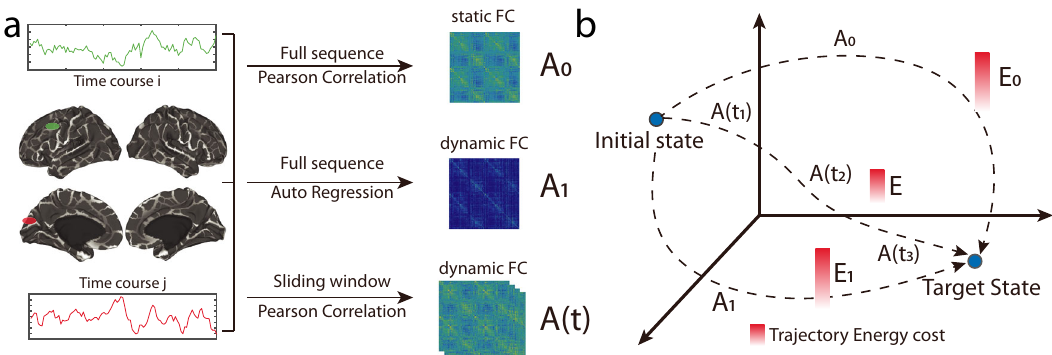
Fig. 1 Conceptual schematic. a We begin with the preprocessed BOLD time series from 400 cortical (Schaefer atlas 43 ) and 19 subcortical regions. The static functional connectivity matrix is calculated as the Pearson ’ s correlation across the full-time sequence. Two types of dynamic functional connectivity are estimated by the autoregression approach 38 and the sliding-window approach 6,85 , respectively. b For a pair of given initial and target states, different types of interaction matrices would result in distinct trajectories thus varied